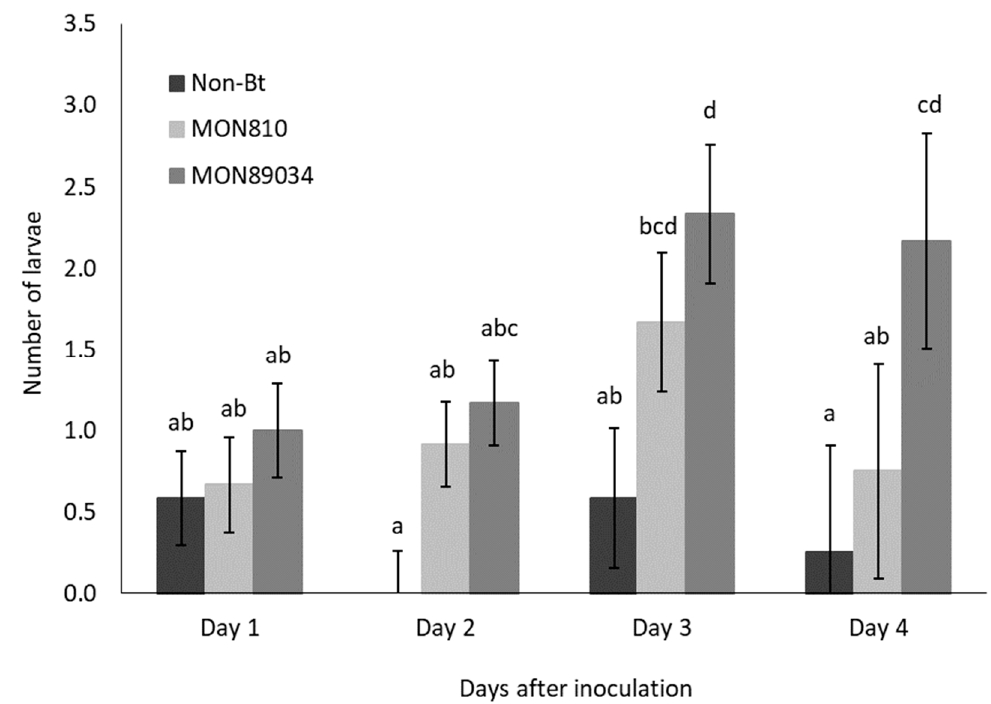
Figure 2. Mean ( ± SE) number of Bt-susceptible B. fusca larvae to abandon maize plants per day (V4 growth-stage) over a 4-day period after inoculation onto non-Bt, MON810, and MON89034 plants. Means marked with different letters for each day-interval are significantly different ( p < 0.05). The experiment was conducted in November 2018 and replicated 12 times for each population, with n = 30 larvae inoculated per plant.